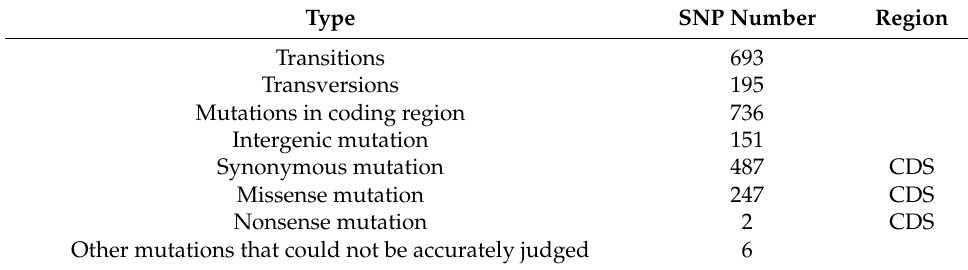
Table 6. Summary statistics of SNP base changes of BmNPV YN.